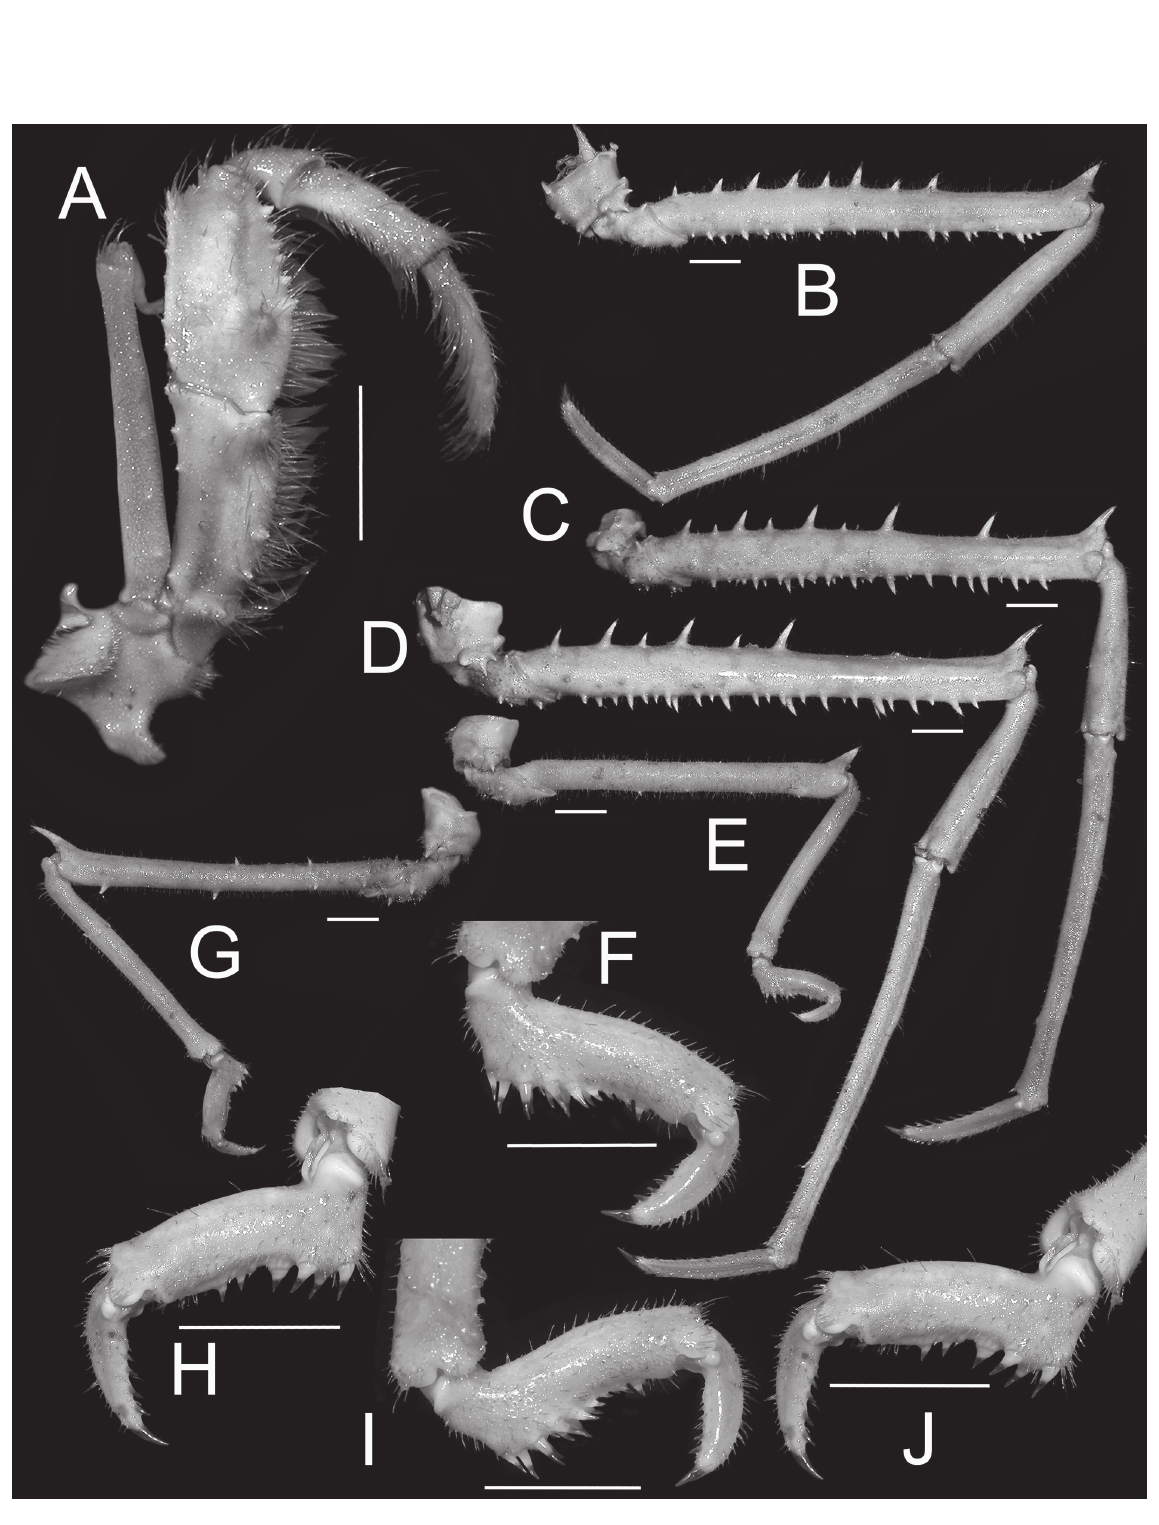
Fig. 12. Moloha alisae Guinot & Richer de Forges, 1995. A – H . ♂ (cl 67.7 mm, cw 56.2 mm) (ZRC 2008.1250a), South Africa. I – J . ♂ (cl 67.5 mm, cw 56.5 mm) (ZRC 2008.1250b), South Africa. — A . Right third maxilliped. B – E . Right P2–P5, respectively. F , I . Right P5 subchelate dactylus and propodus. G . Left P5. H , J . Left P5 subchelate dactylus and propodus. Scale bars =